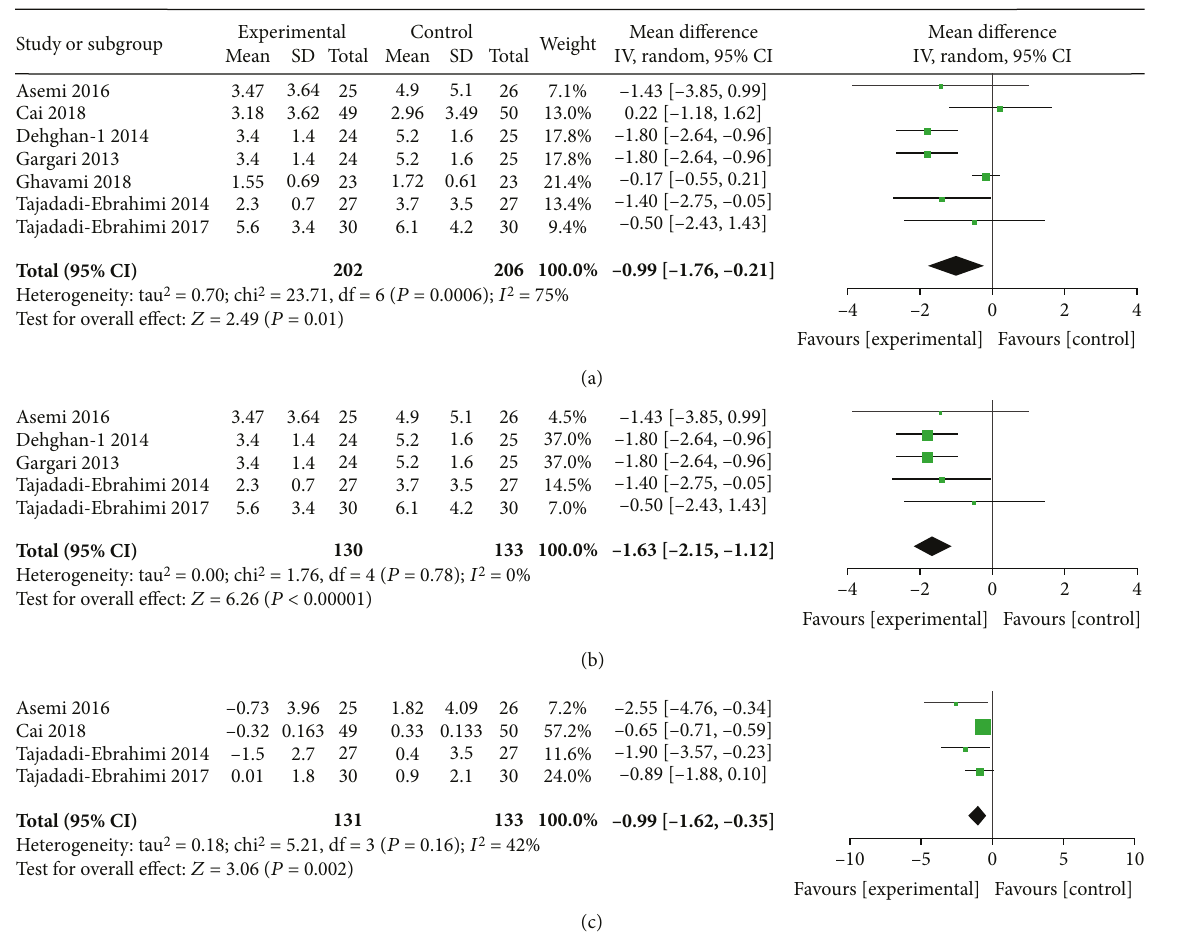
Figure 7: Findings of a meta-analysis of studies with continuation data on amelioration in HOMA-IR for ITC vs. control groups, with estimated MD and 95% CI. (a) Postintervention data of HOMA-IR, (b) subgroup analysis for postintervention data according to the baseline BMI level, and (c) reduction data of